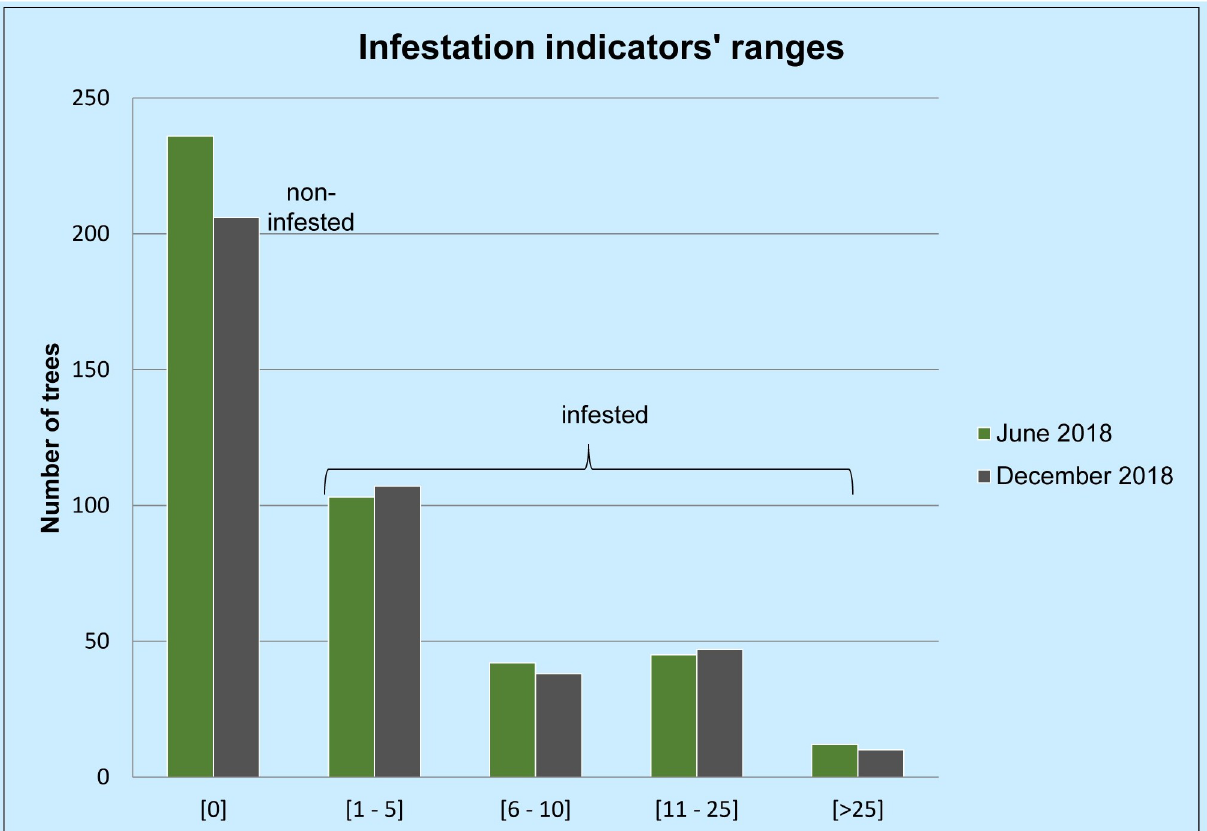
Fig 7. Graph sorting trees according their sum number of infestation indicators (EH+BI+GS) in June and in December 2018.